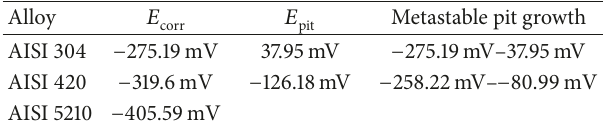
Table 2: Characteristic values of polarization scans in 3.5 wt.% NaCl solution.